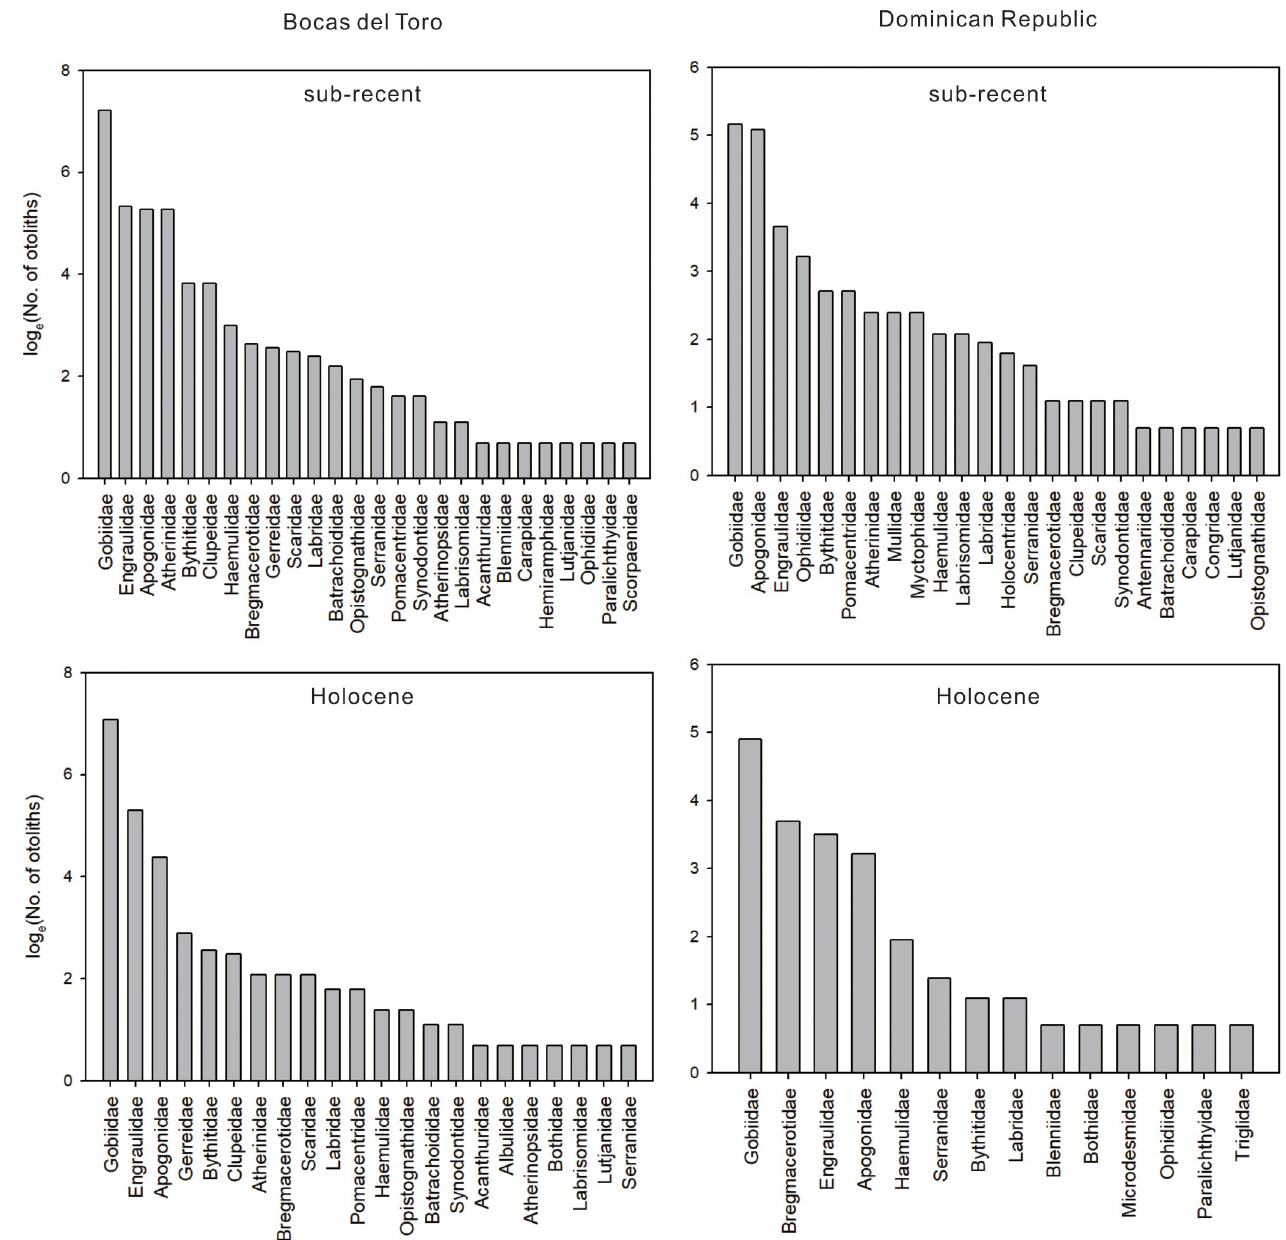
Fig 11. Rank-abundance of otolith families in sites from sub-Recent (top) and mid-Holocene (bottom) coral reefs in Bocas del Toro, Panama (left) and the Dominican Republic (right). Note that otolith counts are